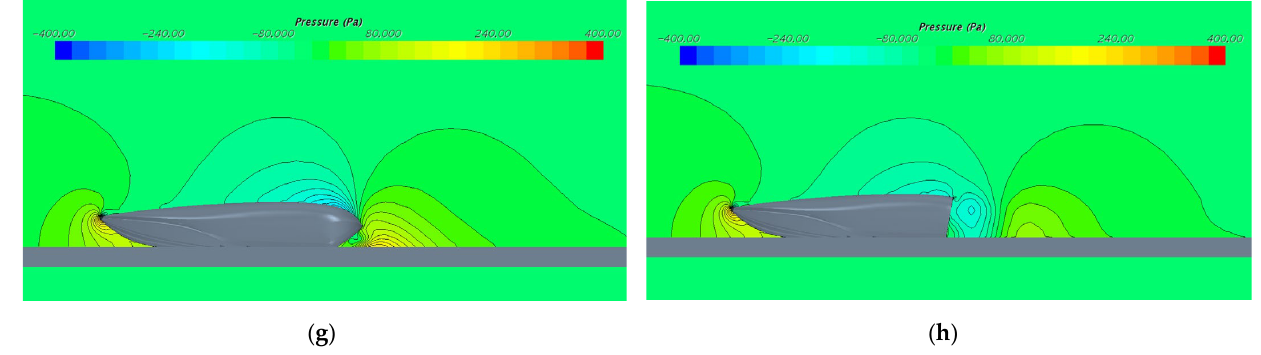
Figure 9. Pressure distribution in middle longitudinal profile of each model at 25 m/s: ( a ) Model A01; ( b ) Model A02; ( c ) Model B01; ( d ) Model B02; ( e ) Model C01; ( f ) Model C02; ( g ) Model D01; and ( h ) Model D02.